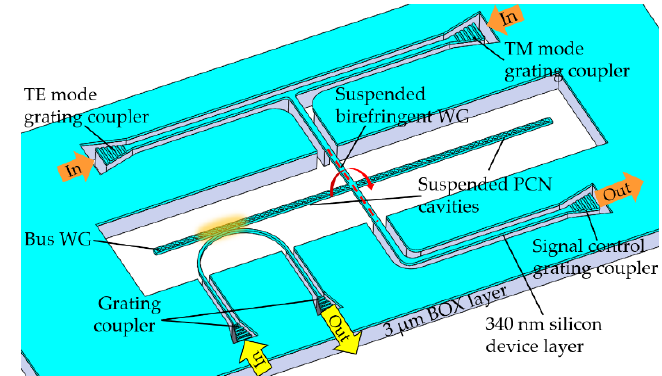
Figure 26. Optomechanical spin angular momentum sensor using a suspended waveguide–nanobeam structure [146].